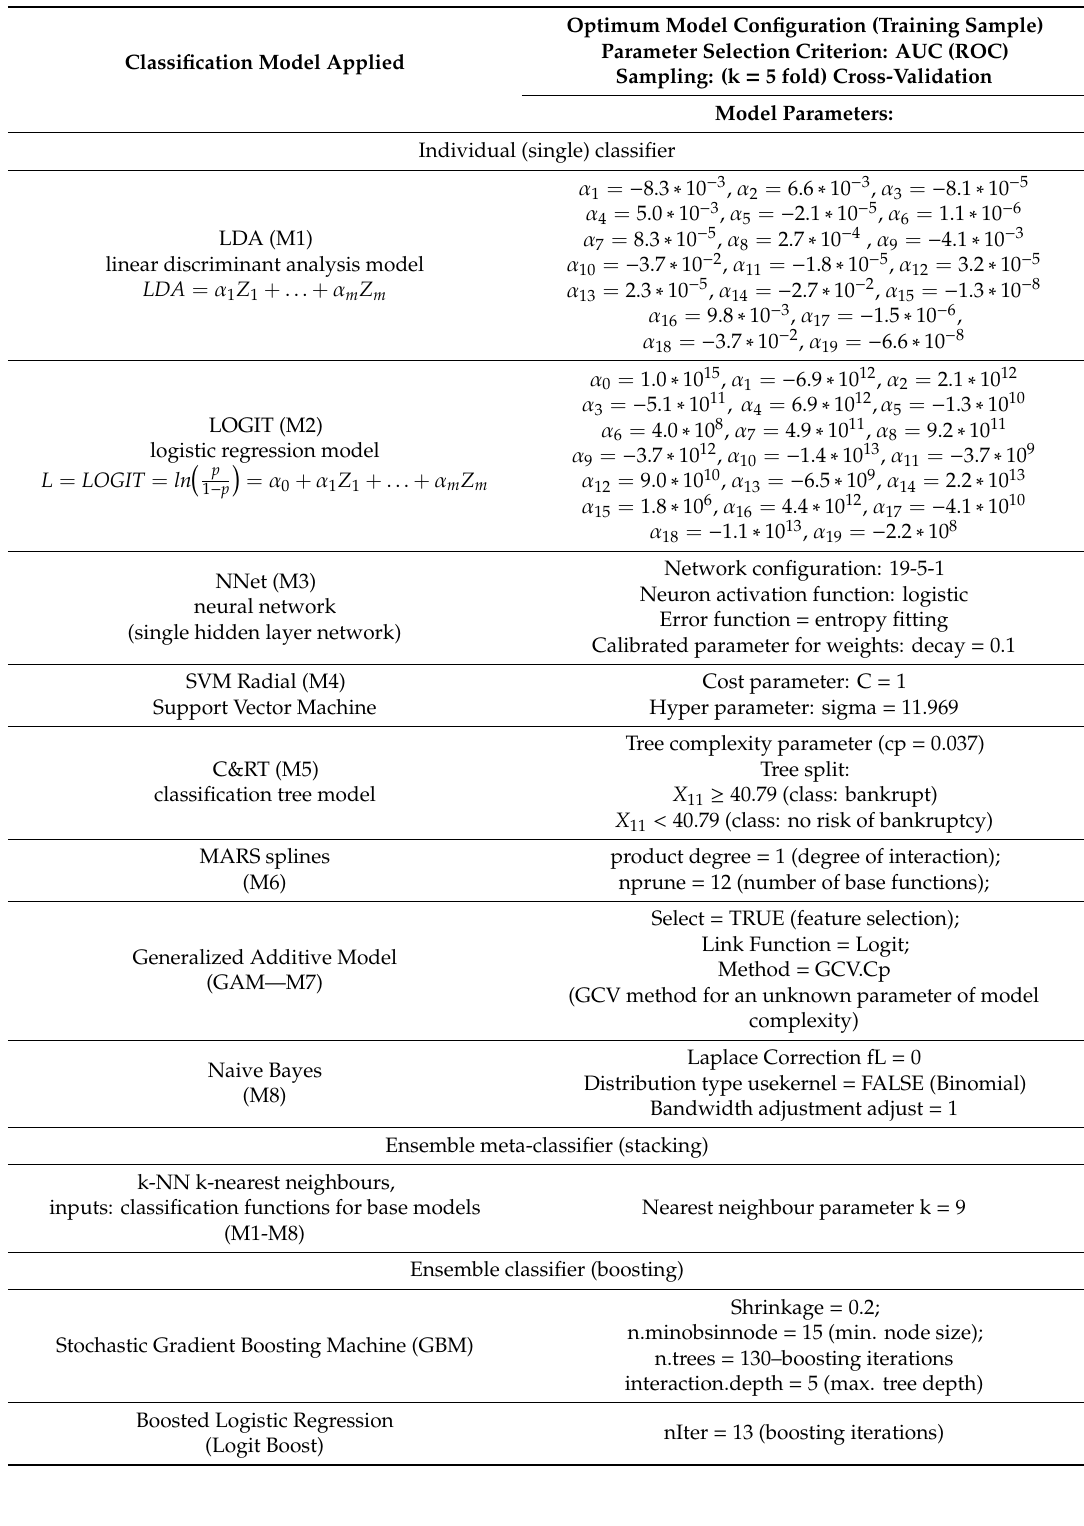
Table A1. Optimum configuration and set of parameters for bankruptcy models